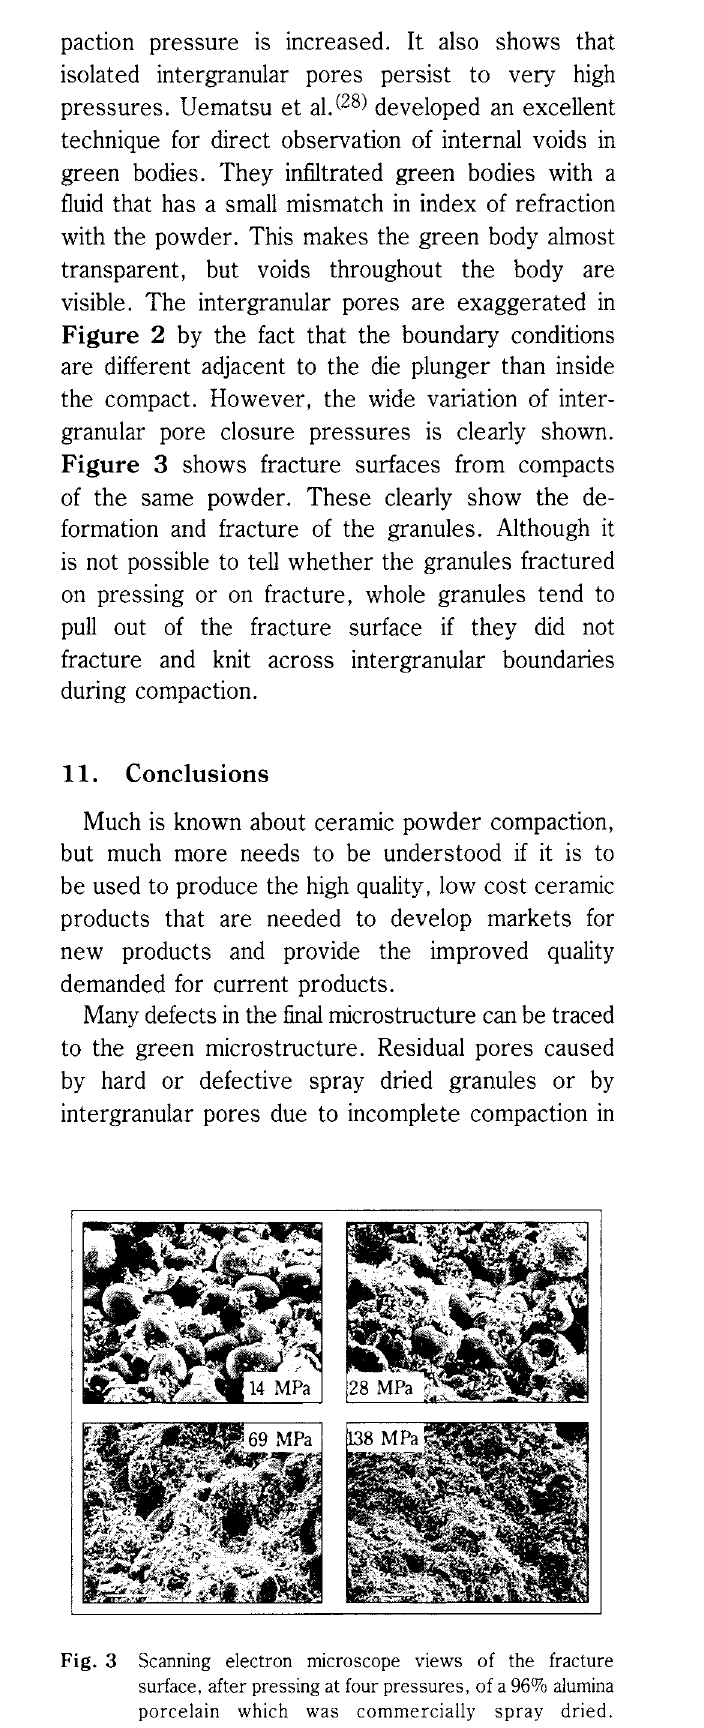
Fig. 3 Scanning electron microscope views of the fracture surface, after pressing at four pressures, of a 96% alumina porcelain which was commercially spray